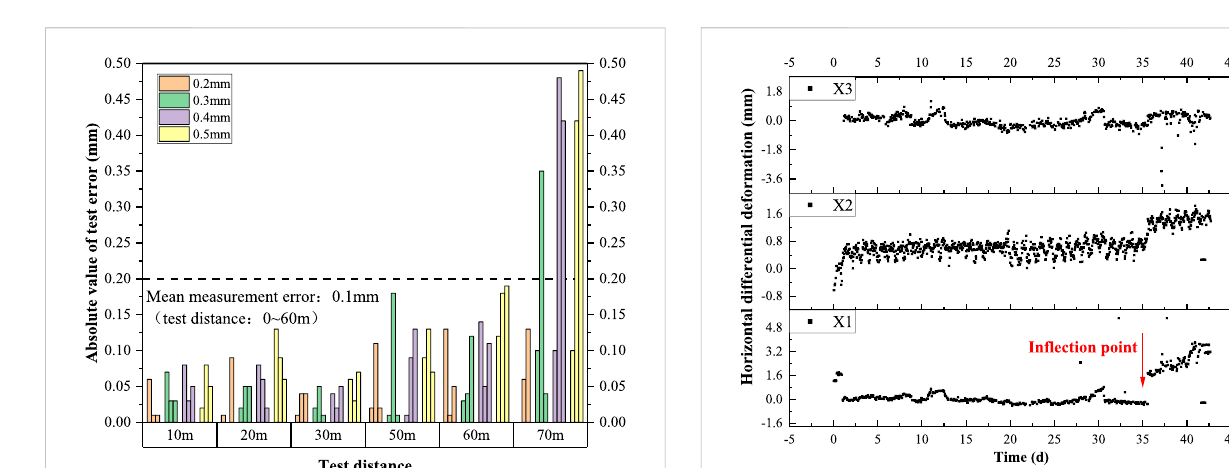
FIGURE 17 Scatter diagram of time domain analysis on monitoring results of horizontal differential deformation of joints at different measuring